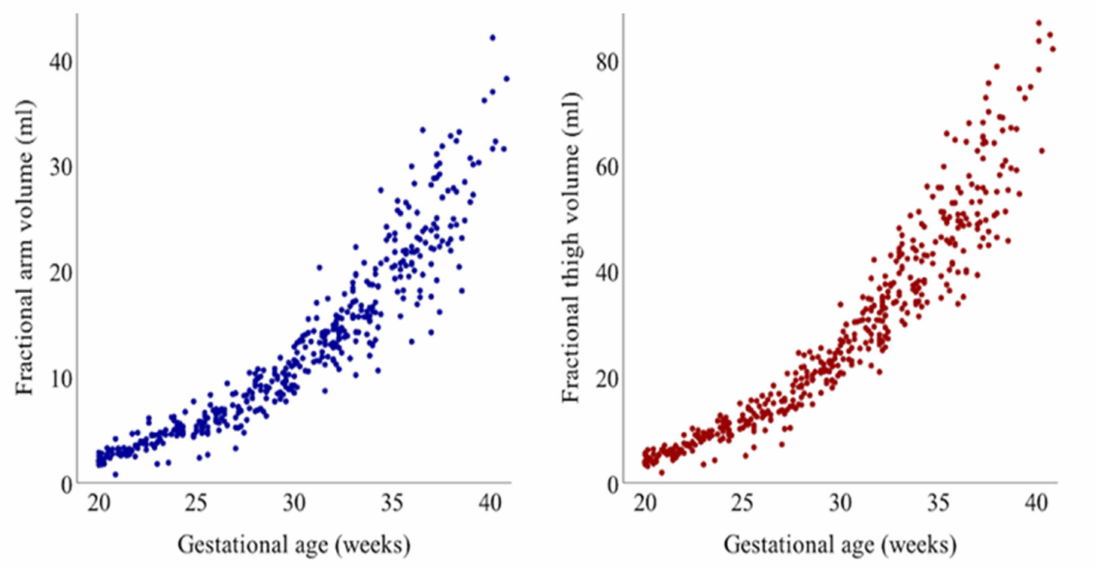
Figure 1. Scatterplot of fractional arm volume and thigh volume across